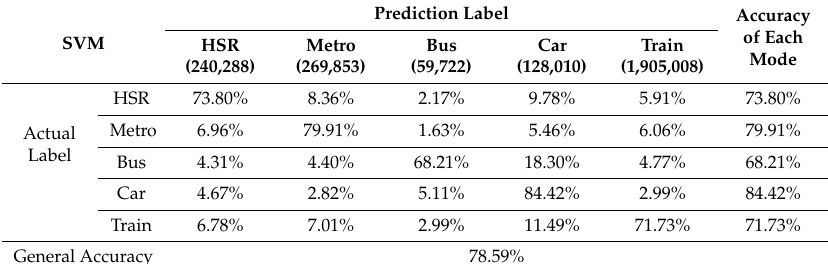
Table 11. Confusion matrix for support vector machine with the proposed